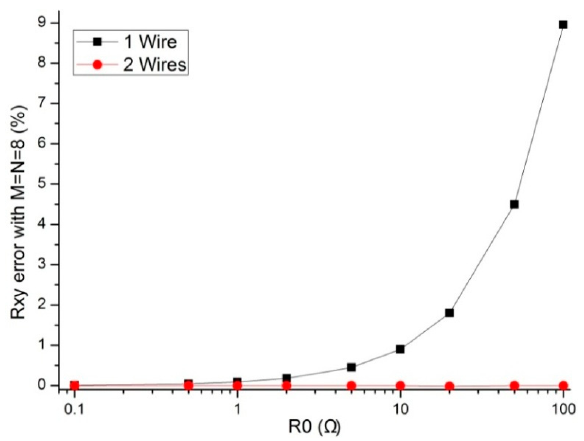
Figure 2. Effect of R 0 on the R xy errors in the one-wire VF-NSDE circuit and the two-wire VF-NSDE circuit where M = N = 8.